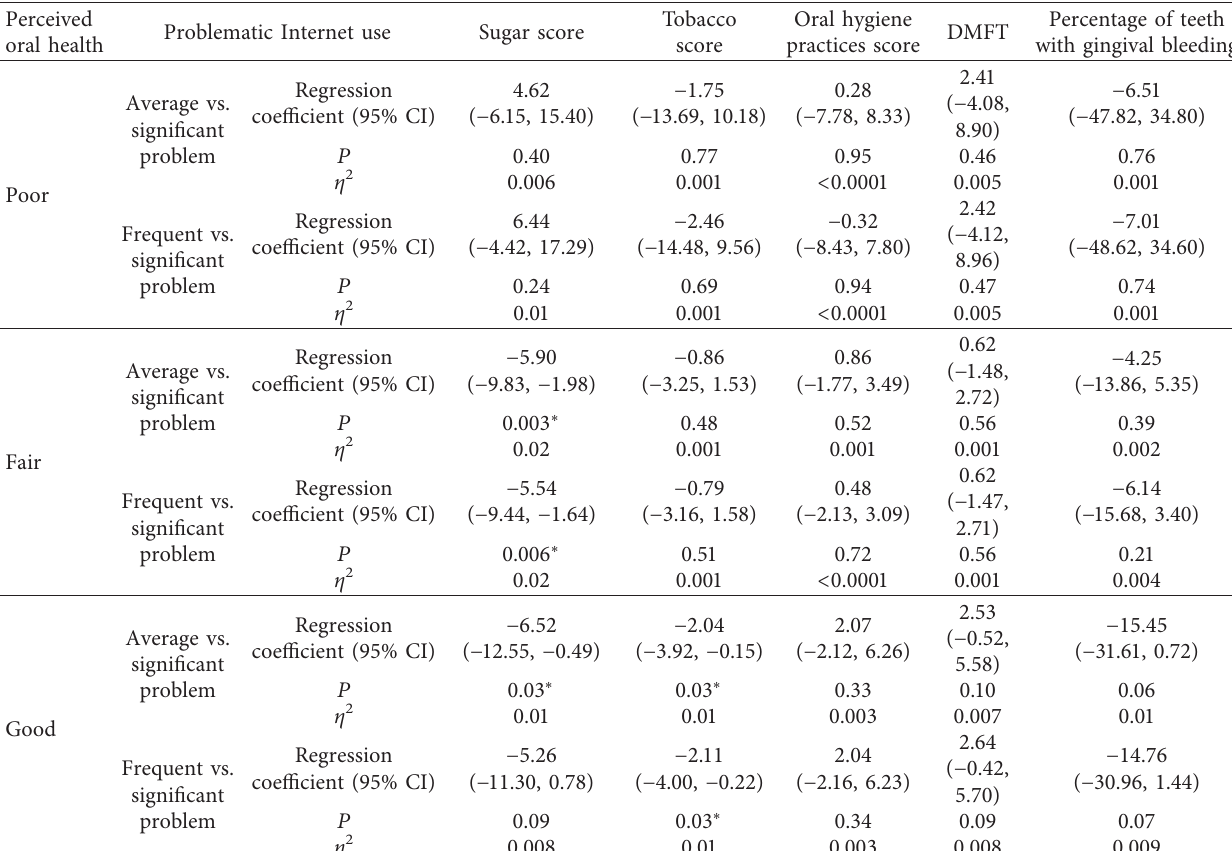
Table 2: Association of Internet use with oral health practices and clinical outcomes stratified by the perception of oral health. Perceived oral health Average vs. Poor Frequent